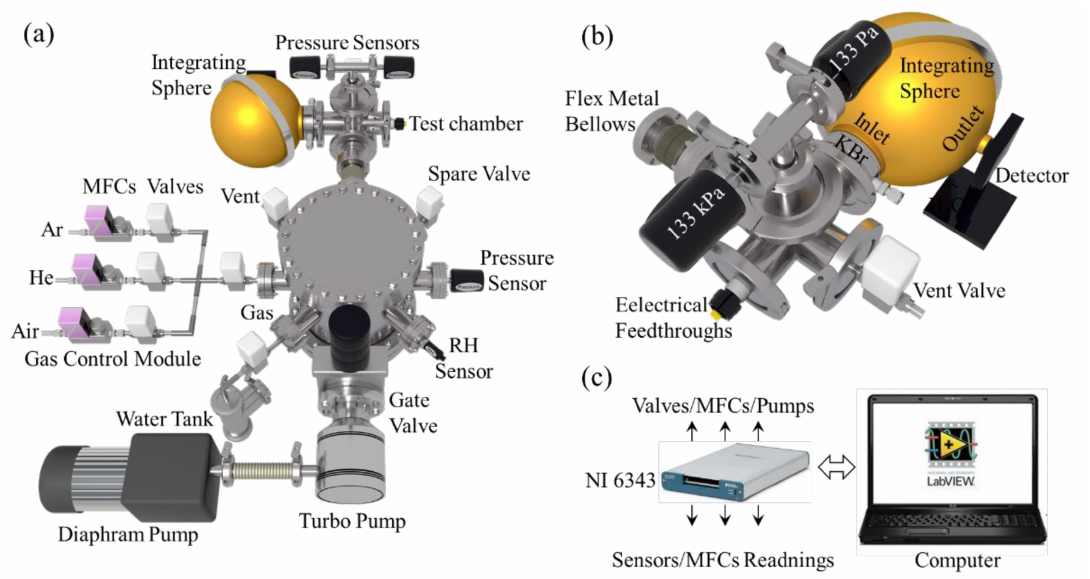
Figure 2. A schematic of the multifunctional electro-optical conversion efficiency measurement system. ( a ) An overview of the environmental control and EOC test modules, ( b ) the back view of the EOC test module, and ( c ) the system control